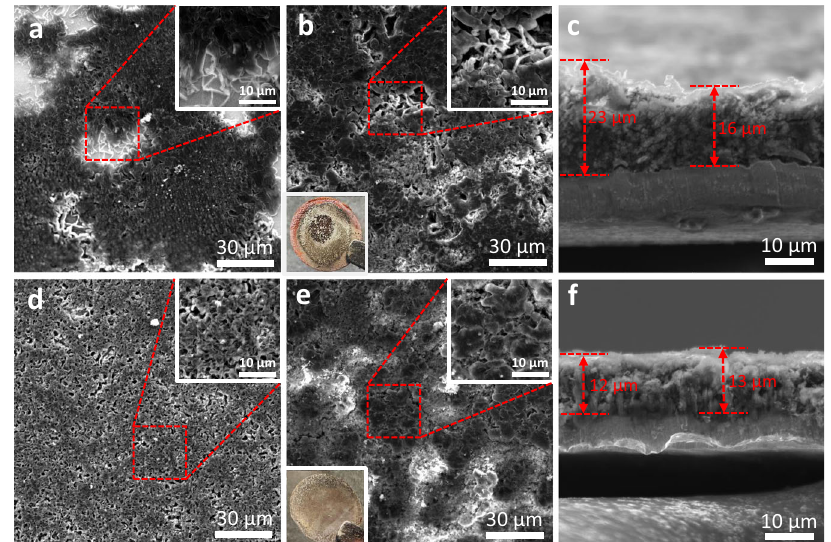
Fig. 2 Li plating morphology on Cu foil in Li|Cu half cells. SEM images of the Li plating morphology after the fi rst cycle in 1 M LiFSI-DME ( a ) and 1 M LiFSI- DTDL ( d ) electrolytes, insets are zoom-in images of highlighted regions. SEM images and optical photographs of the Li plated electrodes after 20 cycles in 1 M LiFSI-DME ( b ) and 1 M LiFSI-DTDL ( e ) electrolytes, insets are optical and zoom-in images. Cross-sectional SEM images of plated Li after 20 cycles in